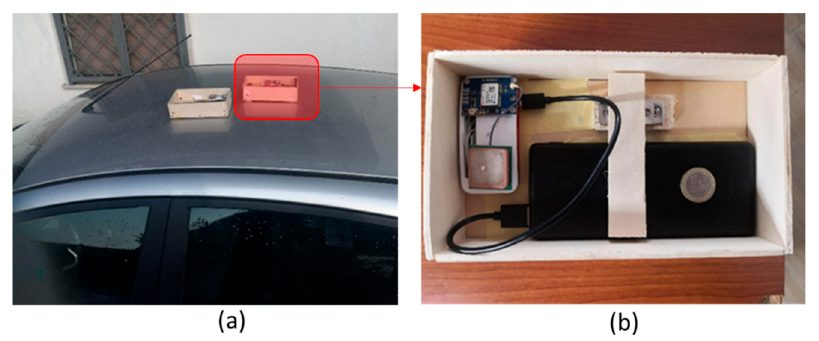
Figure 13. Installation of the prototypes on the car body: ( a ) position of the sensor and ( b ) magnetic case.